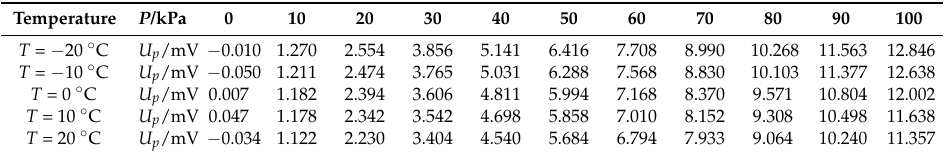
Table 2. The calibration sample data of PS3/PS4 sensors for the training of the GA-WNN, which are obtained with pressures from 0 to 100 kPa and with temperatures from − 20 to 20 ◦